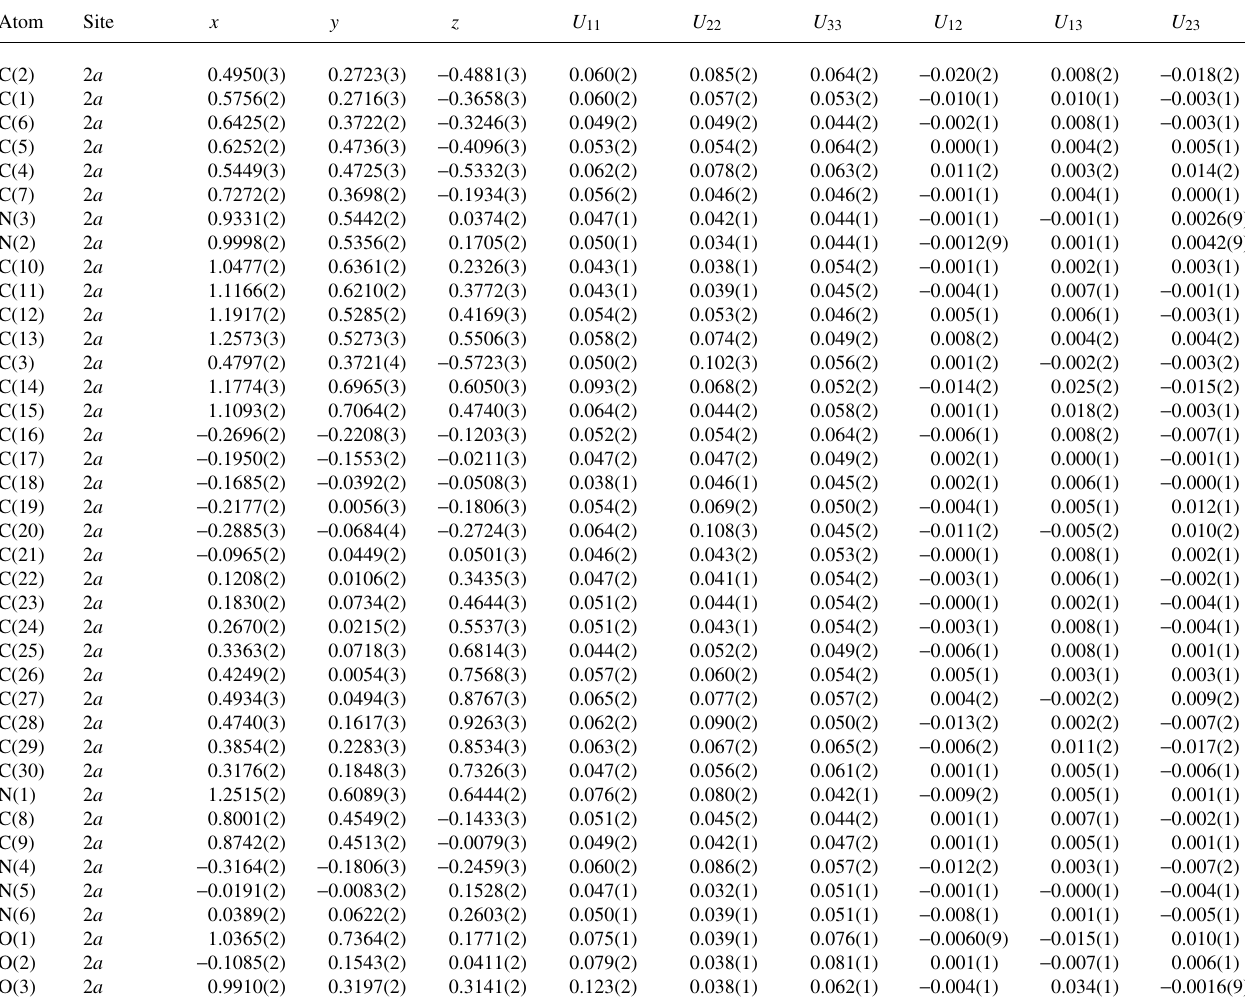
Table 3. Atomic coordinates and displacement parameters (in Å 2 )